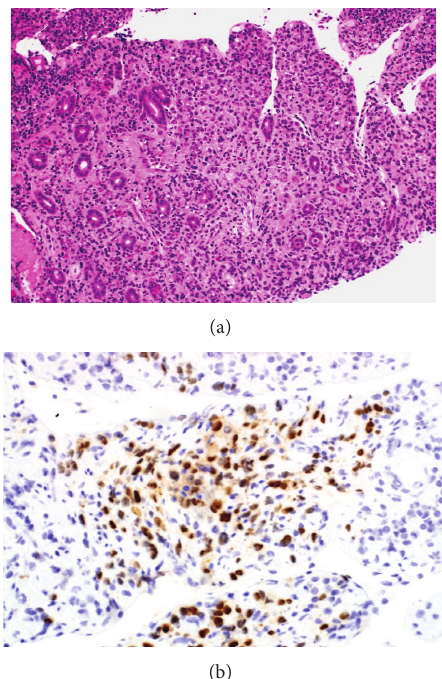
Figure 2: (a) Section from the duodenal biopsy showed infiltration of the lamina propria by poorly differentiated neoplastic cells with rare cells exhibiting intracytoplasmic lumen with mucin or eccentric nuclei suggesting a poorly differentiated adenocarcinoma. The neo- plastic cells where positive for CK (AE1/AE3), CK7, and (b) ER and negative for PR. The morphology as well as immunohistochemical studies were consistent with poorly differentiated